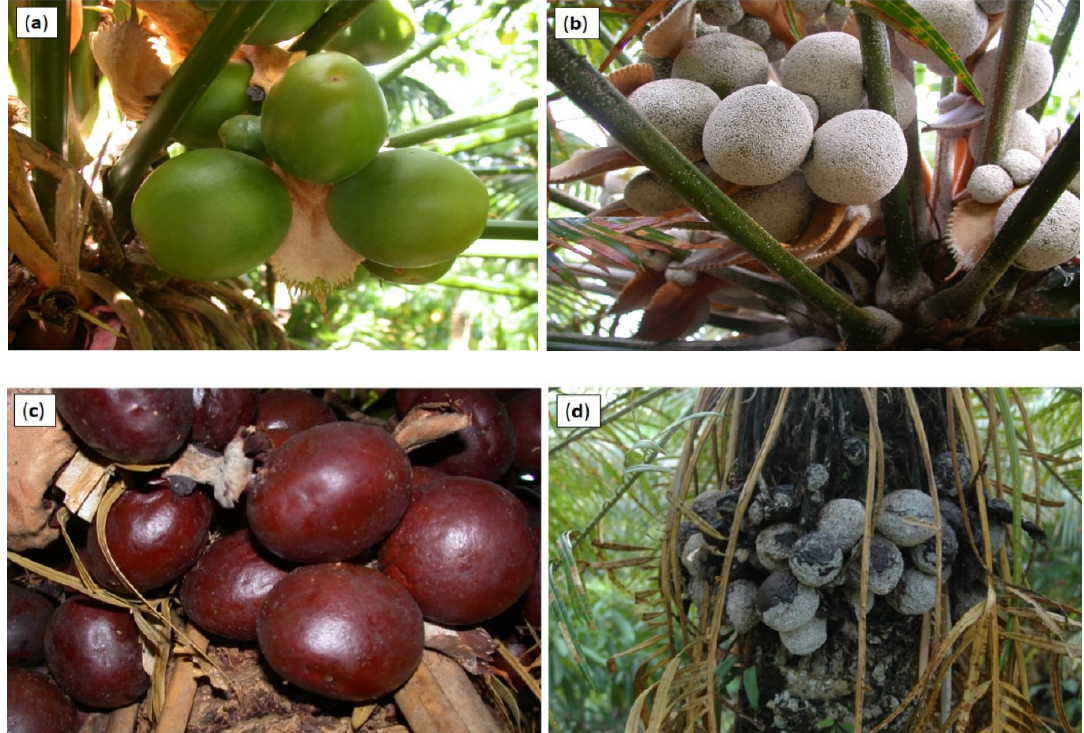
Figure 2. Cycas micronesica seeds with or without direct Aulacaspis yasumatsui infestations. ( a , b ) Six months in age; ( c , d ) 18 months in